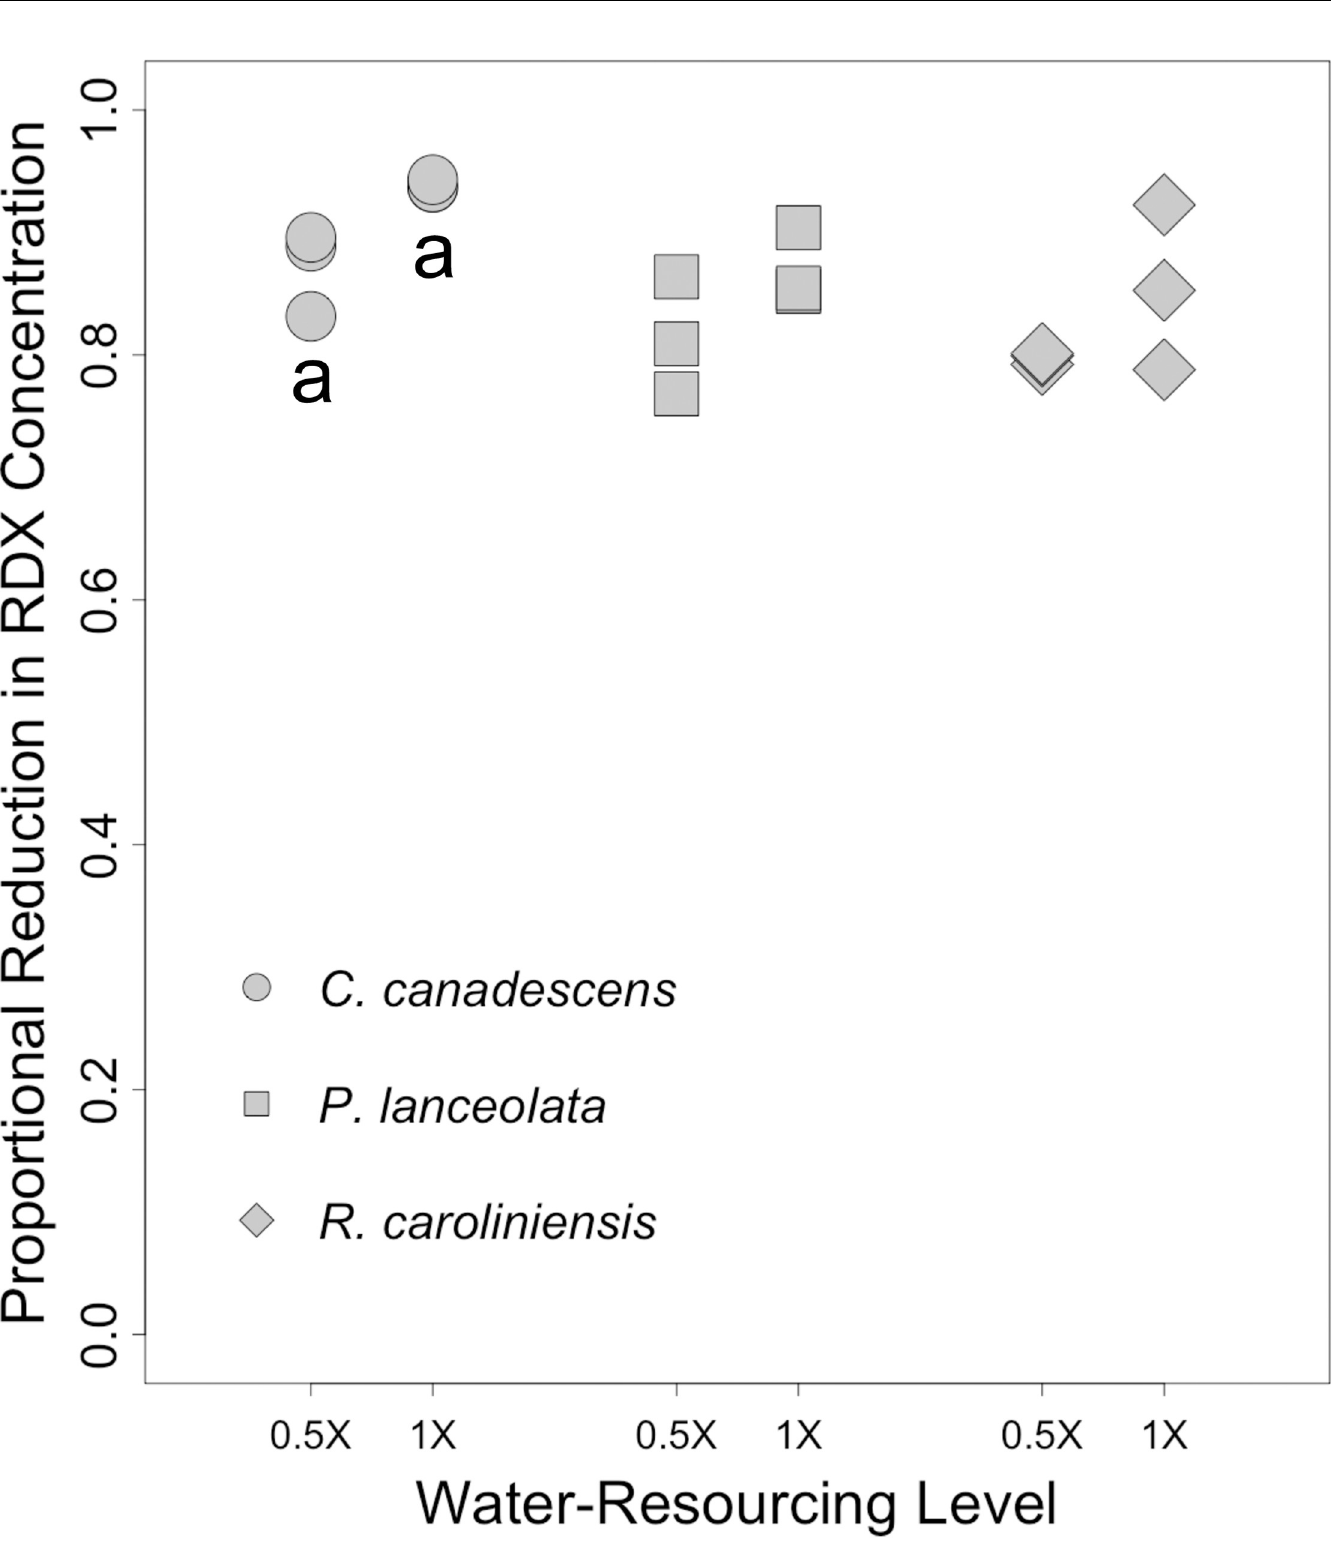
Fig 7. Proportional reductions in soil RDX concentrations in outdoor trials. Proportional reductions in concentration ( PRC s) in soils from pots containing three different plant species maintained outdoors with either a 1X or 0.5X water-resourcing treatment for at least 41 days. Initial concentration of RDX in potting soils was 100 ppm. For each species, soils from n = 3 plants were sampled per treatment group. a = significant pairwise difference between treatment groups ( p � 0.10).